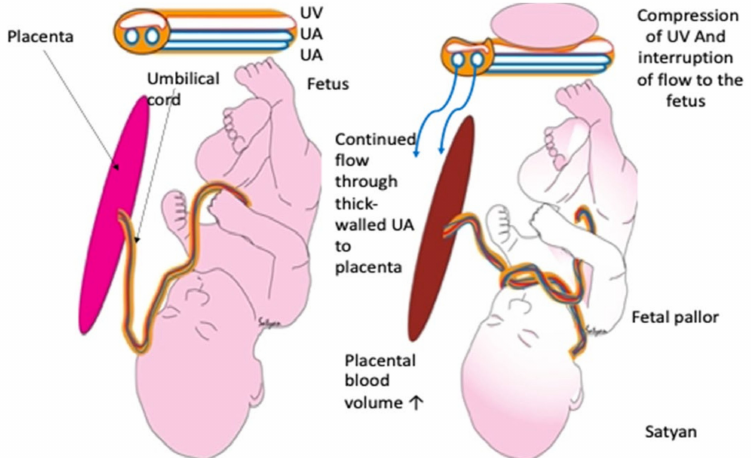
Figure 1. Effects of umbilical cord occlusion on the umbilical vein (UV) and umbilical arteries UA), placenta, and neonate. On the left there is no occlusion; on the right compression of the umbilical vein and interference with the flow from placenta to infant can be seen. Copyright by Satyan Lakshimrusimha, MD. Sacramento, CA, USA. Used with